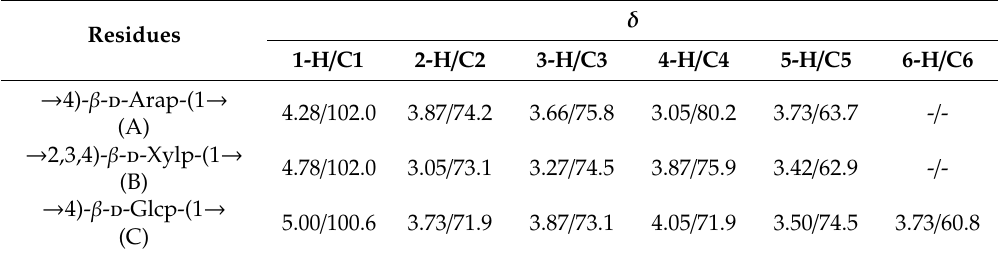
Table 2. Chemical shifts of glycosyl 1 H and 13 C in